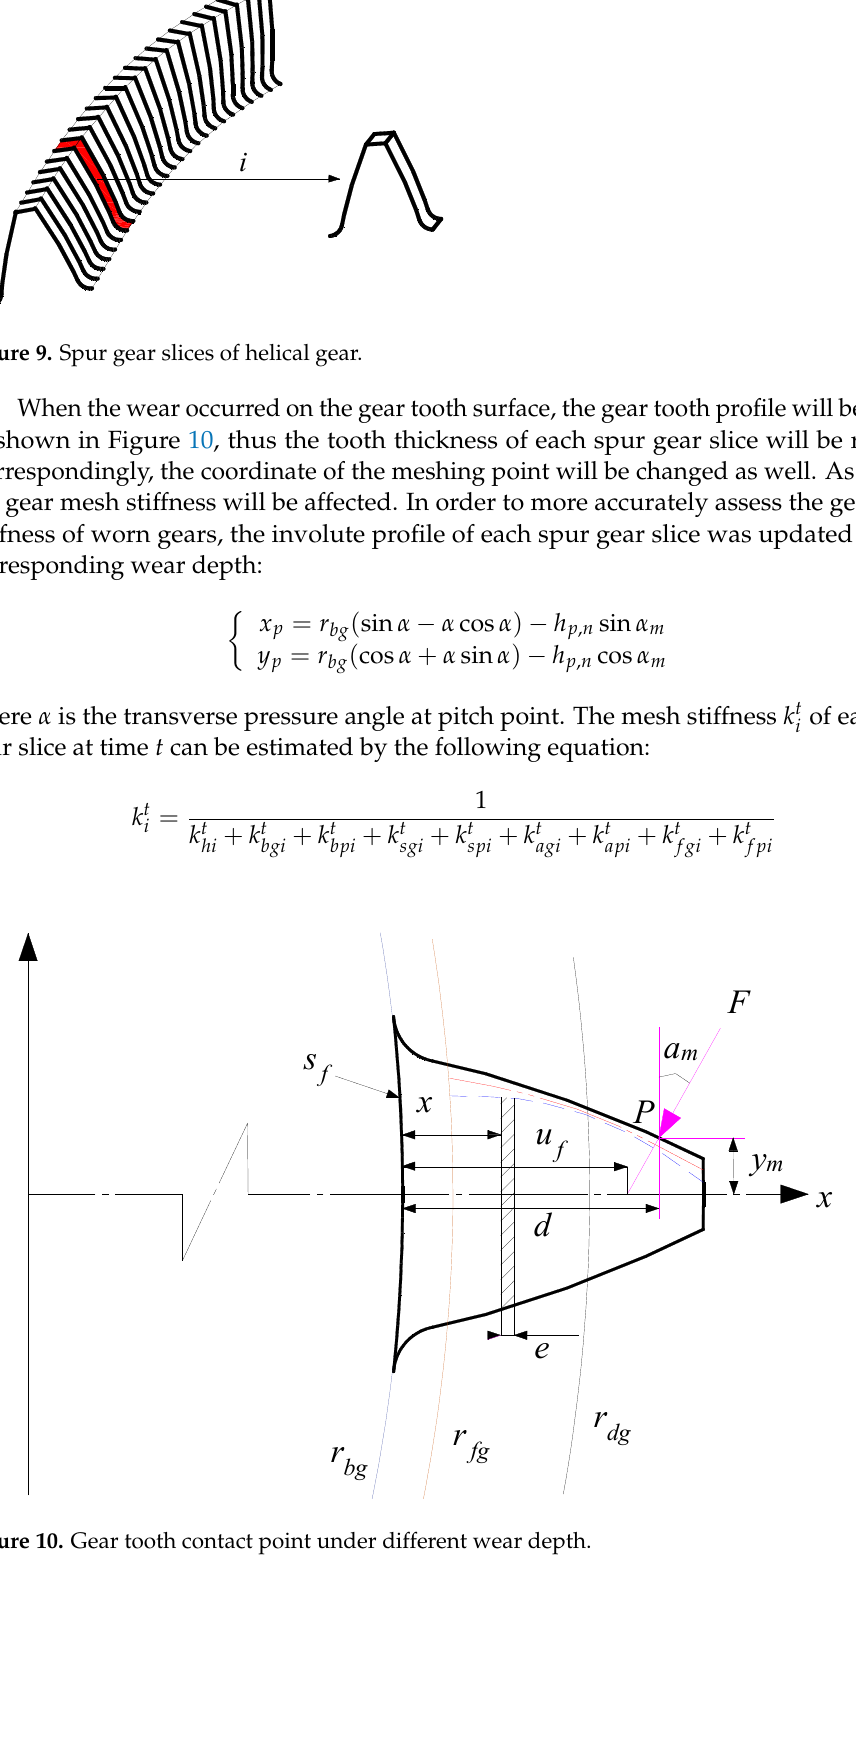
Figure 8. Modelling of nonuniform cantilever beam of spur gear.